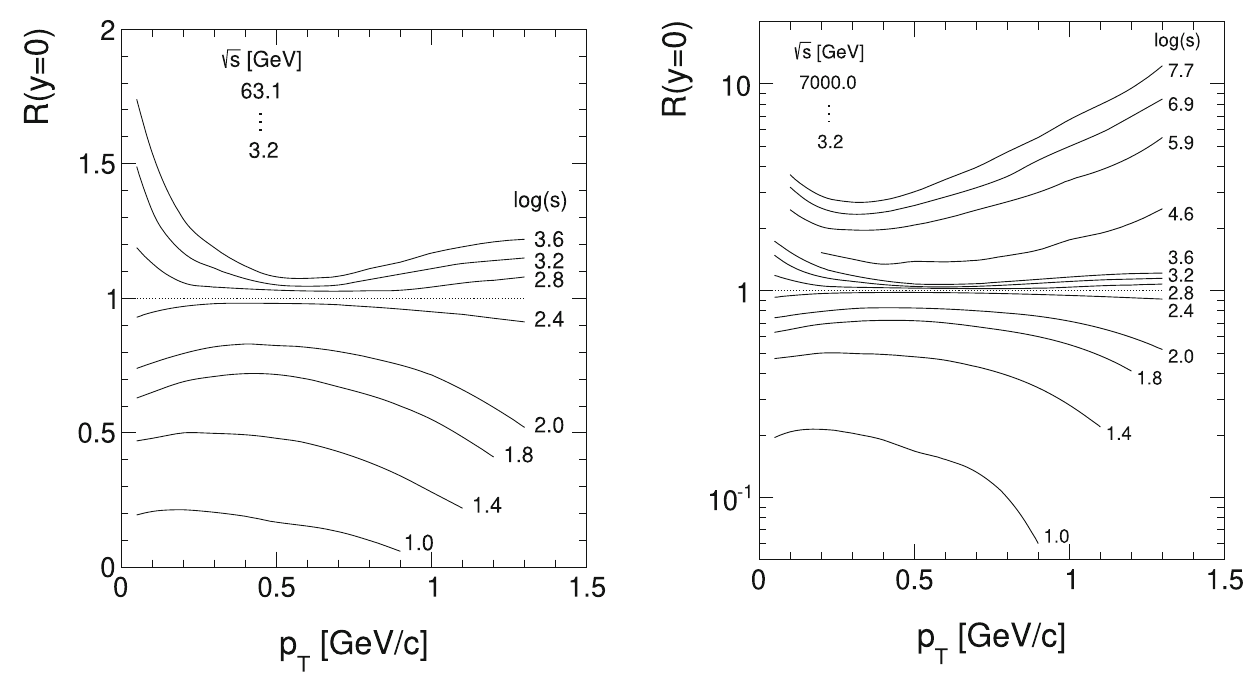
Fig. 122 R ( y = 0 , s , p T ) as a function of p T for 3 GeV to 7 TeV